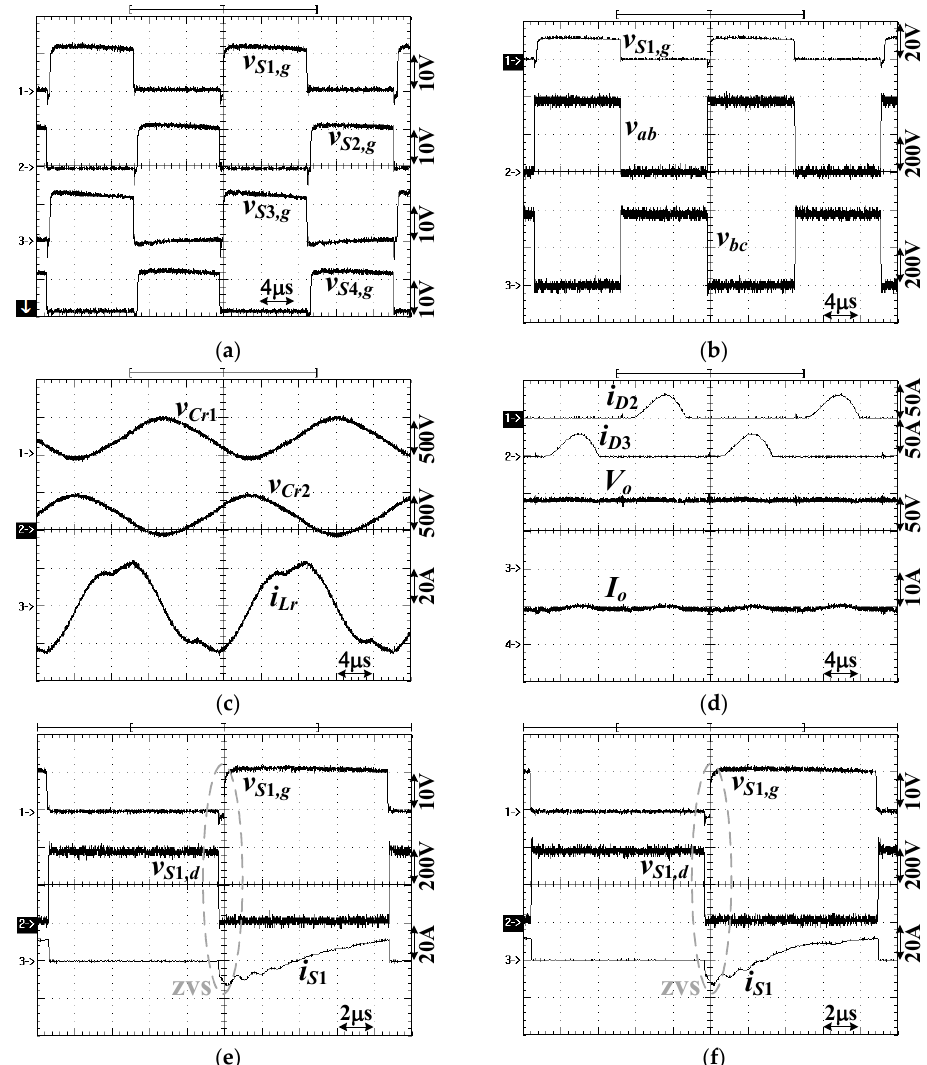
Figure 9. Experiments of the presented converter under V o = 90 V: ( a ) v S 1 ,g , v S 2 ,g , v S 3 ,g , and v S 4 ,g under V in = 760 V and P o = 1 kW; ( b ) v S 1 ,g , v ab , and v bc under V in = 760 V and P o = 1 kW; ( c ) v Cr 1 , v Cr 2 , and i Lr under V in = 760 V and P o = 1 kW; ( d ) i D 2 , i D 3 , V o , and I o under V in = 760 V and P o = 1 kW; ( e ) v S 1 ,g , v S 1 ,d , and i S 1 under V in = 760 V and P o = 200 W; and ( f ) v S 1 ,g , v S 1 ,d , and i S 1 under V in = 760 V and P o = 1 kW.